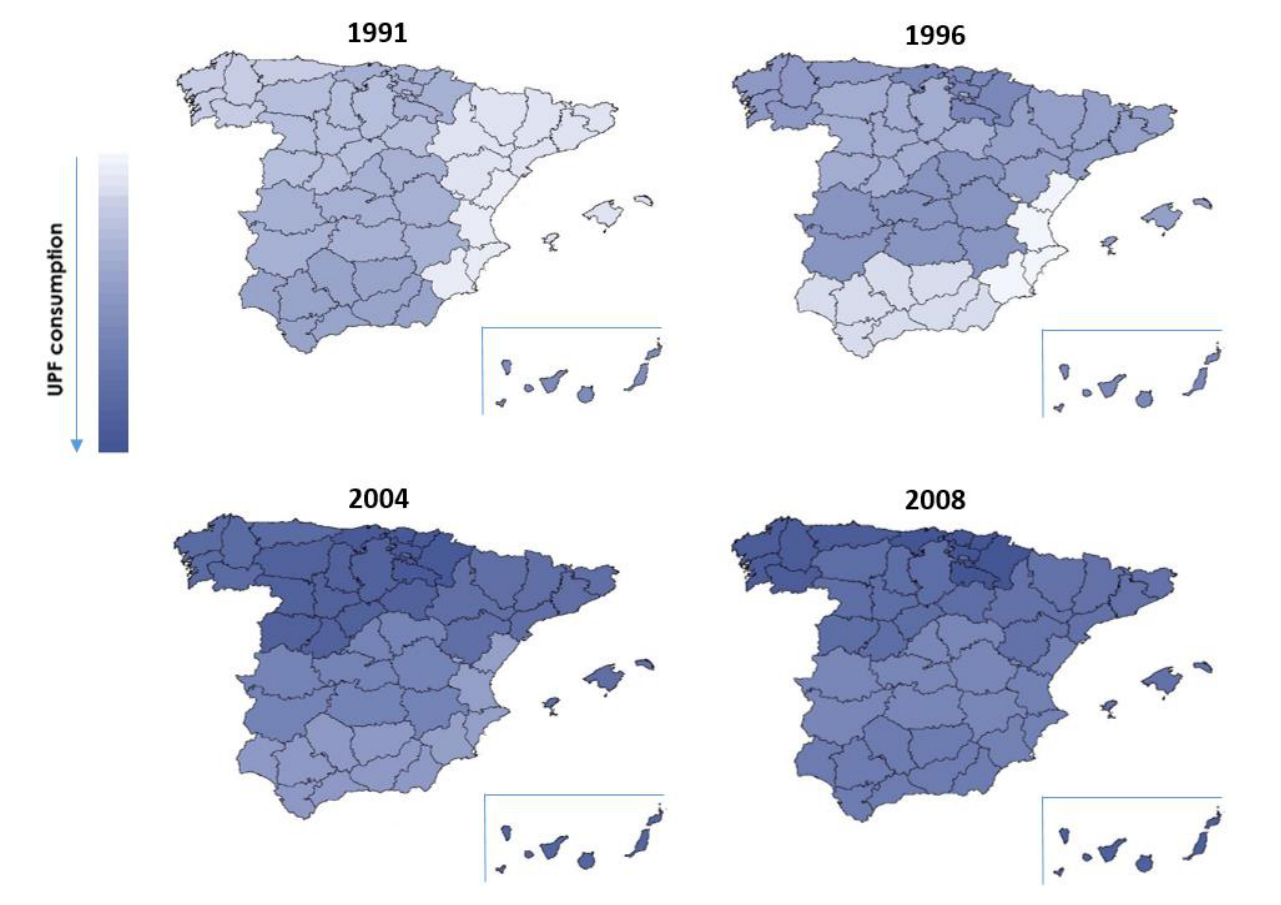
Figure 4. Geographical distribution of ultra-processed food consumption in Spain over time.